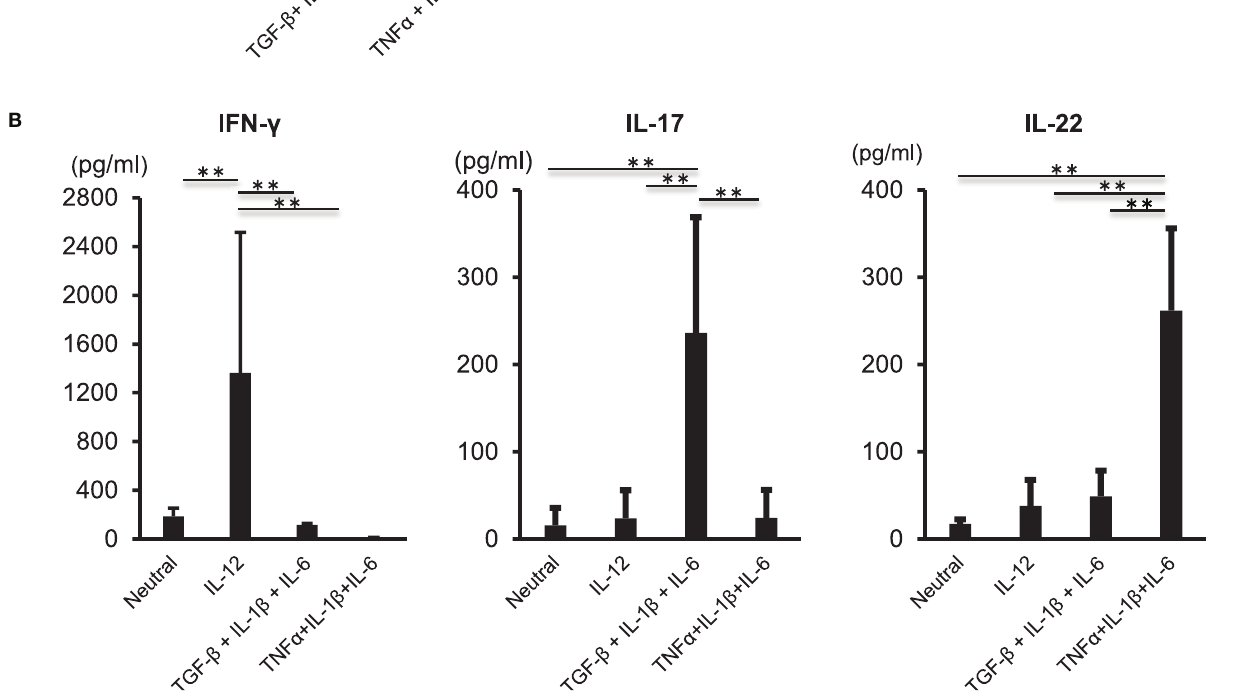
Frontiers in Immunology | www.frontiersin.org